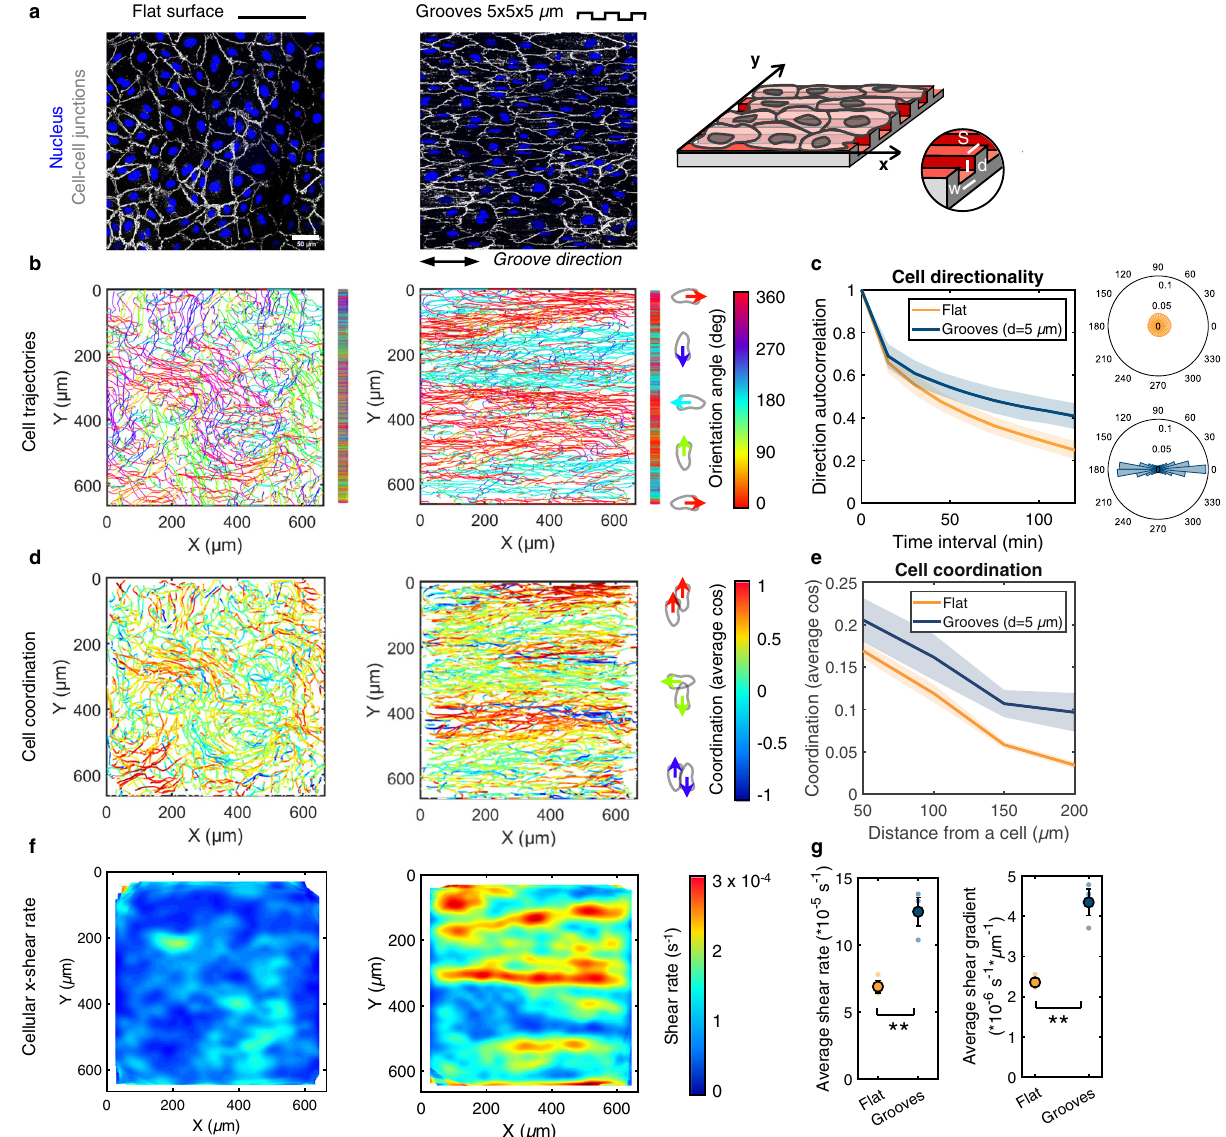
Fig. 1 Endothelial cells on grooved substrates migrate with a periodic pattern of antiparallel cell streams. a Monolayers of endothelial cells (HUVECs) on a control fl at substrate or substrate with grooves of width, spacing, and depth of 5 µ m, immunostained for VE-cadherin (cell-cell junctions, white) and DAPI (nucleus, blue). Scale bar, 50 µ m and double-headed black arrow indicates groove direction. The grooved substrate is shown schematically on the right. b Accumulated cell trajectories after 24h of migration color-coded for the orientation of each displacement vector. Vertical bars to the right of the trajectory maps represent the projected trajectories on the y-axis for better visualization of the cell streams. c Direction autocorrelation analysis: the cosine of the angular difference between increasingly more distant vectors within the trajectory is computed and averaged for all cells (left). Polar histograms on the right show the distribution of displacement orientation angles. d Cell trajectories color-coded for cell-cell coordination, de fi ned as the cosine of the angular difference between a cell and its neighbors within a 100 µ m radius. Values of 1 and -1 indicate parallel and antiparallel displacements, respectively. e Evolution of the coordination parameter with increasingly distant neighbors. f Heatmaps of cellular x-direction shear rate, extracted from the x-velocity fi eld. g Average x-direction shear rate and shear gradient in the y-direction. Dots represent individual experiments. Unpaired t -test (** p < 0.001). For all graphs, n = 3 independent experiments and error bars represent SEM (standard error of the mean). Source data are provided as a Source Data fi